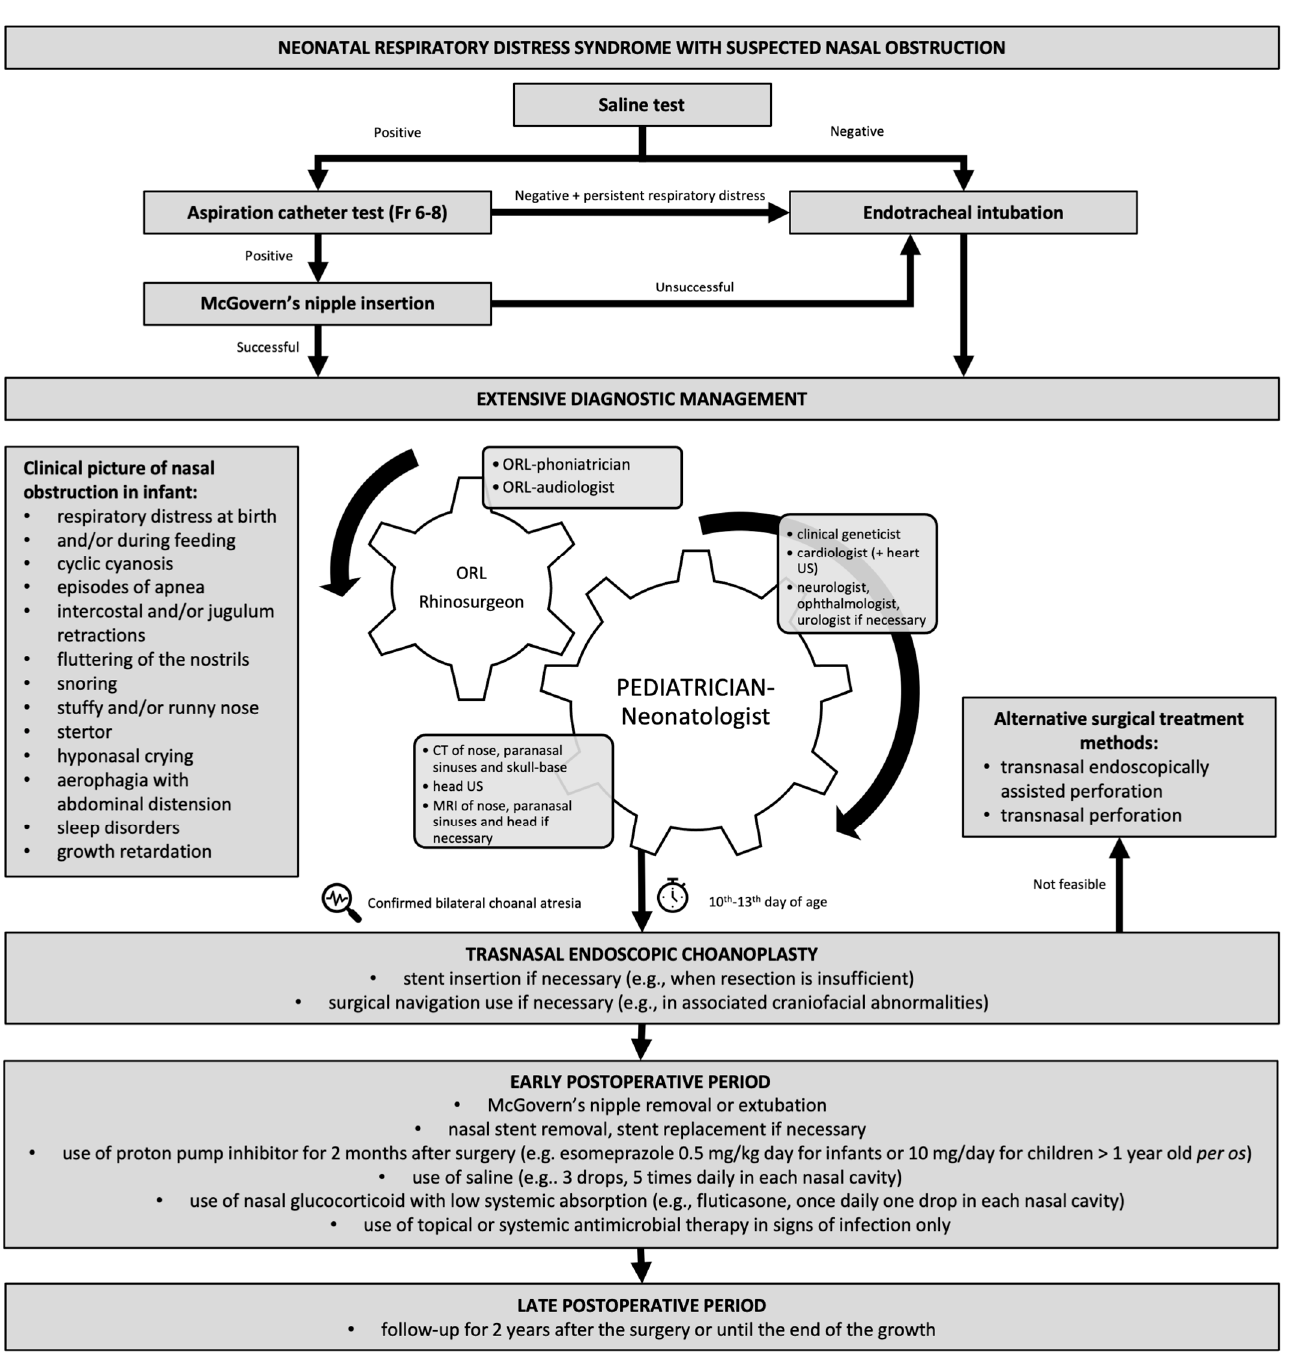
Figure 1. Algorithm for neonatal respiratory distress syndrome due to nasal obstruction caused by bilateral choanal atresia. The paediatrician and otorhinolaryngologist play a leading role in extensive diagnostic management. In cooperation with the otorhinolaryngologist, the paediatrician also takes care of coordination in treating the child by other specialists and for imaging and diagnostic evaluation. The otorhinolaryngologist primarily provides management by other subspecialist otorhinolaryngologists. A positive saline and aspiration catheter test means that the saline or catheter does not pass through the nasal cavity into the pharynx.